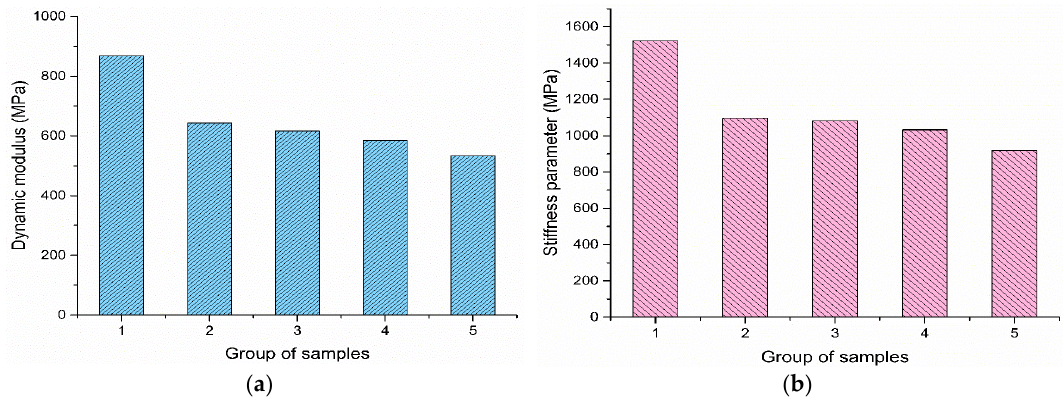
Figure 9. The variations of dynamic modulus and the stiffness parameter of five groups of samples (10 Hz, 50 °C): ( a ) |E*|; ( b ) |E*|/sinδ.